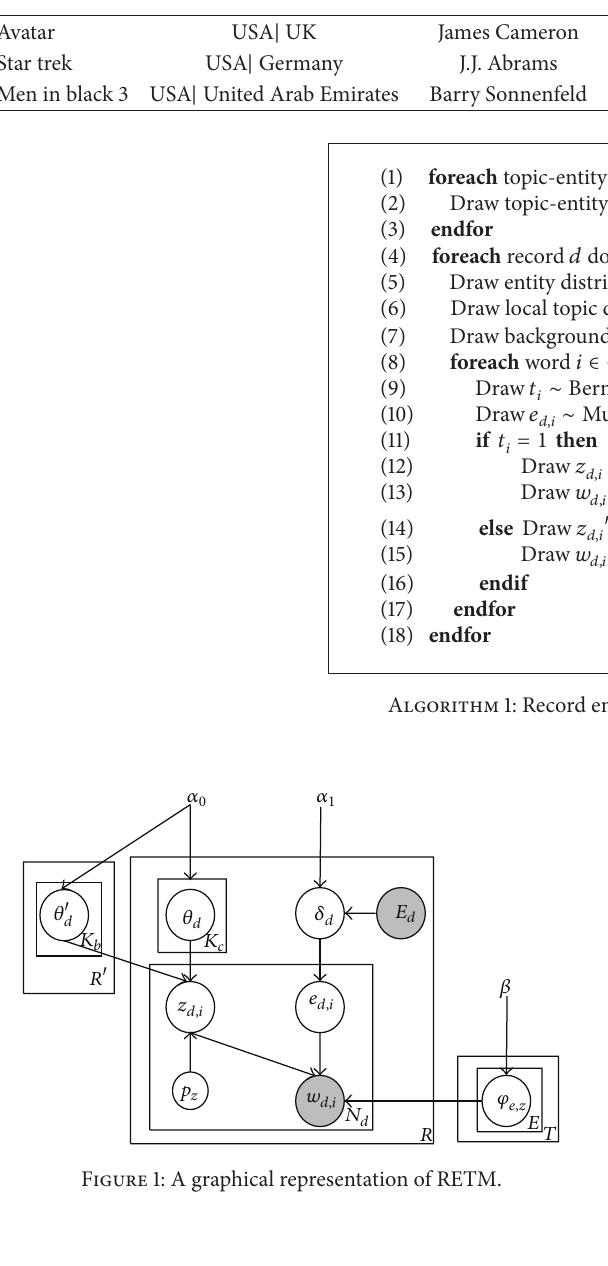
Table 1: Example of query records from IMDB (movies).